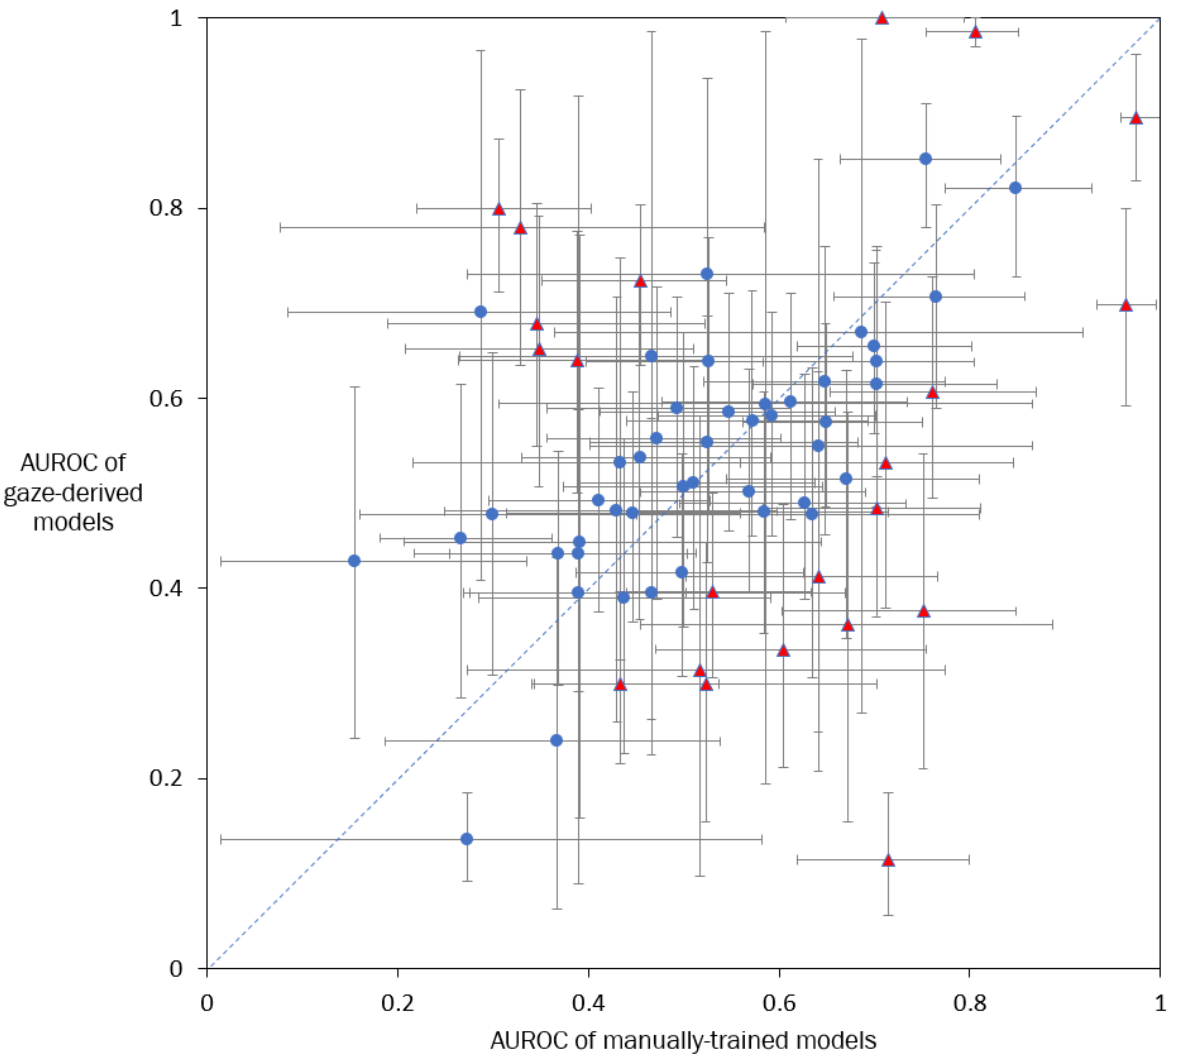
Figure 2. Performance of models used to predict the relevance of targets. The x-axis value and y-axis value of each point indicate the area under the receiver operating characteristic curve (AUROC) values of a pair of manual selection and gaze-derived models, respectively. The vertical and horizontal lines indicate 95% confidence intervals of the AUROC values. The diagonal line indicates equal performance between manual selection and gaze-derived models. Red triangles indicate model pairs where the AUROC value of one model is significantly different than that of the other model ( α